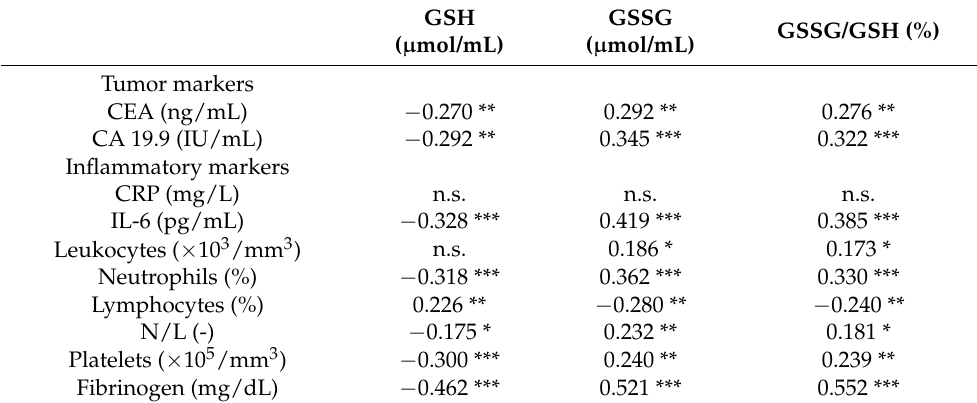
Figure 2. Levels of serum reduced glutathione ( a ), oxidized glutathione ( b ), and percentage ra- tio GSSG/GSH ( c ) in controls and CRC patients. p -value adjusted by age and body mass index (*** p < 0.001). GSH: reduced glutathione; GSSG: oxidized glutathione. Data are expressed as box and whiskers. Table 2. Correlation between serum glutathione levels and GSSG/GSH (%), tumor markers, and biochemical parameters in controls and CRC